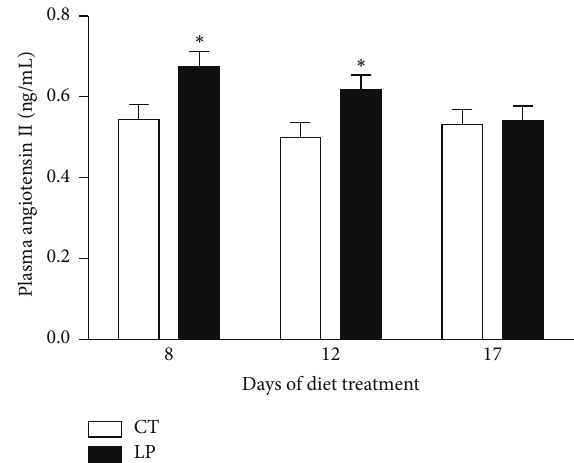
Figure 1: Plasma levels of angiotensin II in nonpregnant rats fed a low-protein diet. CT: control; LP: low-protein. The error bar represents the mean ± SEM ( 𝑛 = 6 rats/diet group/day). ∗ 𝑃 < 0.05